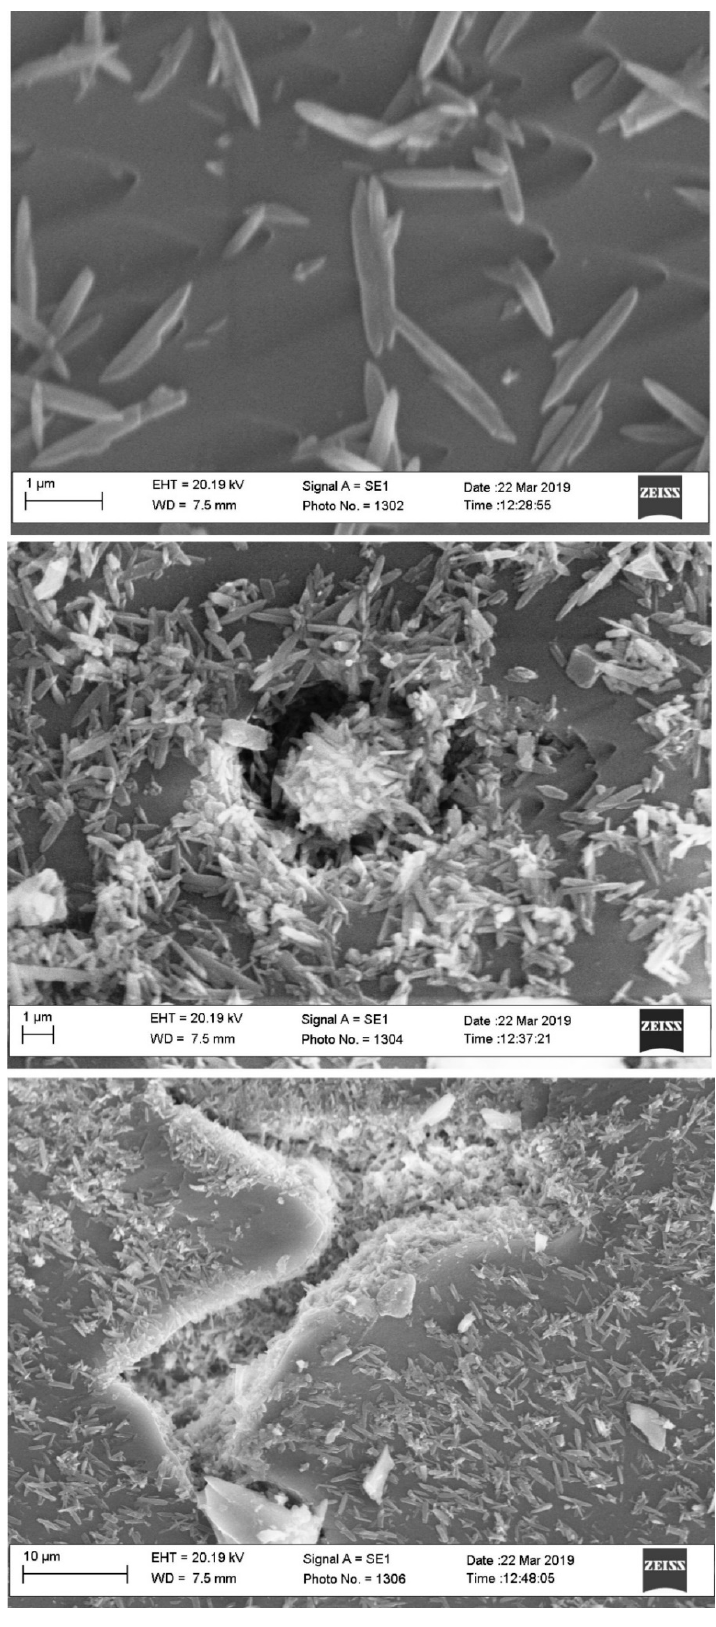
Figure 10. Quartz, 230 MPa: crystallization and growth of quartz microcrystals from silica near fractures and hot spots.